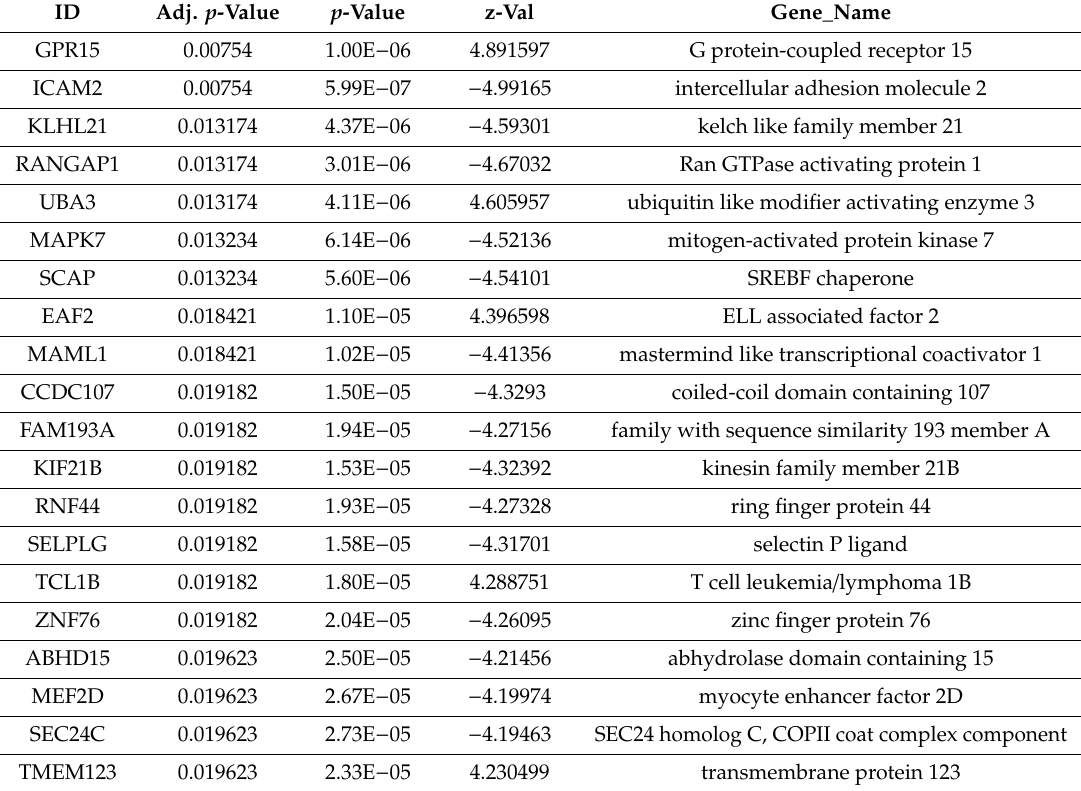
Table 3. Top 20 most significantly modulated genes in PBMCs of schizophrenia patients as compared to healthy donors, as determined from the meta-analysis of GSE18312 and GSE27383